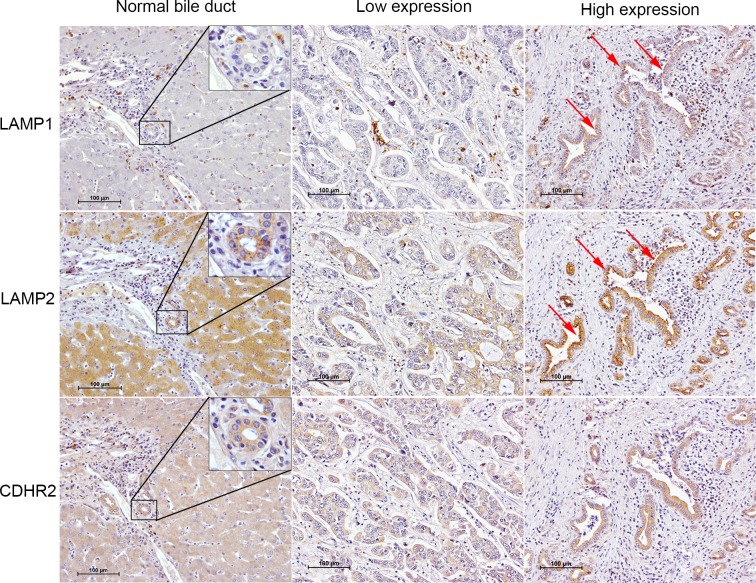
Immunohistochemical staining of three candidate proteins.LAMP1, LAMP2 and CDHR2, was performed on cadaveric donor liver tissues (the first column) and human CCA microtissue arrays which demonstrated low and high expression (the second and third column). The red arrows indicate the positive of LAMP1 and LAMP2 expression at the luminal surface (red arrows).